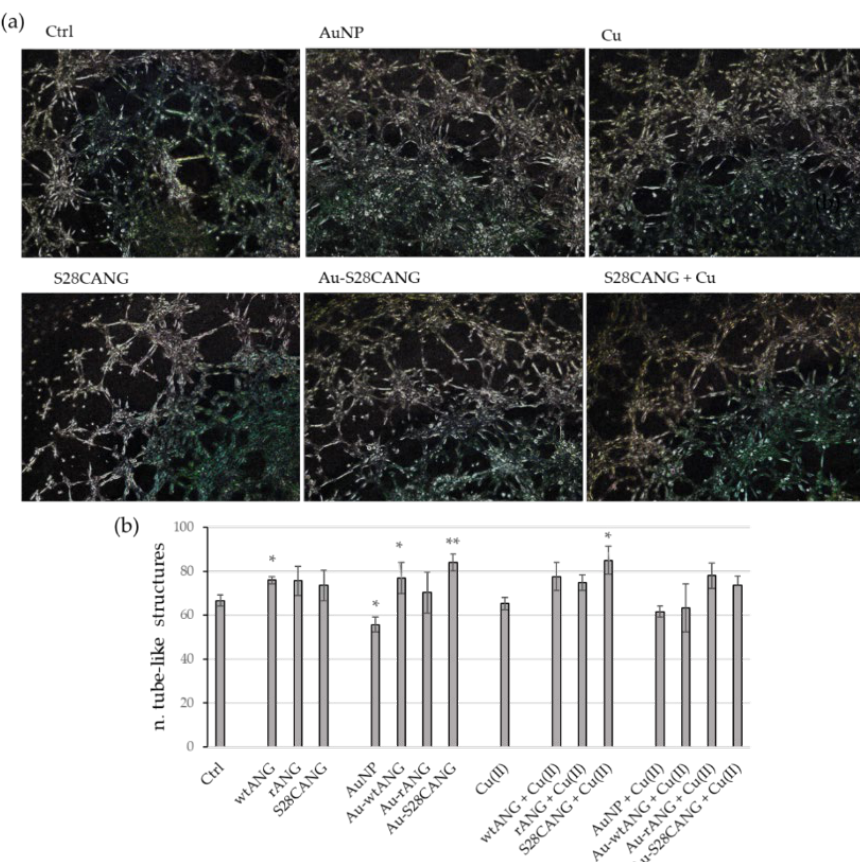
Figure 8. Tube formation assay. ( a ) Representative bright-field optical images of HUVEC cells cultured on Matrigel matrix, untreated and treated for 5 h in M200 supplemented with 1% v/v FBS with: 20 nM free ANG proteins; 100 nM CuSO 4 ; ANG—copper complexes ([Cu(II)]/[ANG] = 5); bare AuNP and AuNP-ANG hybrids, either in the absence or presence of 100 nM CuSO 4 . The following nanoparticle concentrations were used: 0.5 nM AuNP (8.45 × 10 6 NP /mL); 0.2 nM Au-wtANG (2.77 × 10 6 NP /mL); 0.3 nM Au-rANG (2.32 × 10 7 NP /mL); 0.2 nM Au-S28CANG (1.96 × 10 6 NP /mL). ( b ) The number of closed networks of vessel-like tubes was counted from three experiments. Data are mean ± S.D. (*) p < 0.05, (**) p < 0.01 vs. CTRL (Student’s t -test). As to the intracellular Cu(I) staining by the CS1 probe, the quantitative analysis (Figure 9e) shows that, with reference to the positive control of copper-treated cells (Figure 9a), a significant reduction of copper was detected for the HUVECs, after the treatment with Au-wtANG + Cu(II) (Figure 9b), no significant differences were displayed by cell treatment with Au-rANG + Cu(II) (Figure 9c) and a small, but statistically significant increase of intracellular copper for the samples incubated with Au-S28CANG + Cu(II) (Figure 9d) was found. As to the interaction with mitochondria, in general all the treatments with the functionalized nanosystems affected the mitochondrial activity leading to their disfunctions as evidenced by the reduction of the mitochondrial staining in comparison with the control (Figure